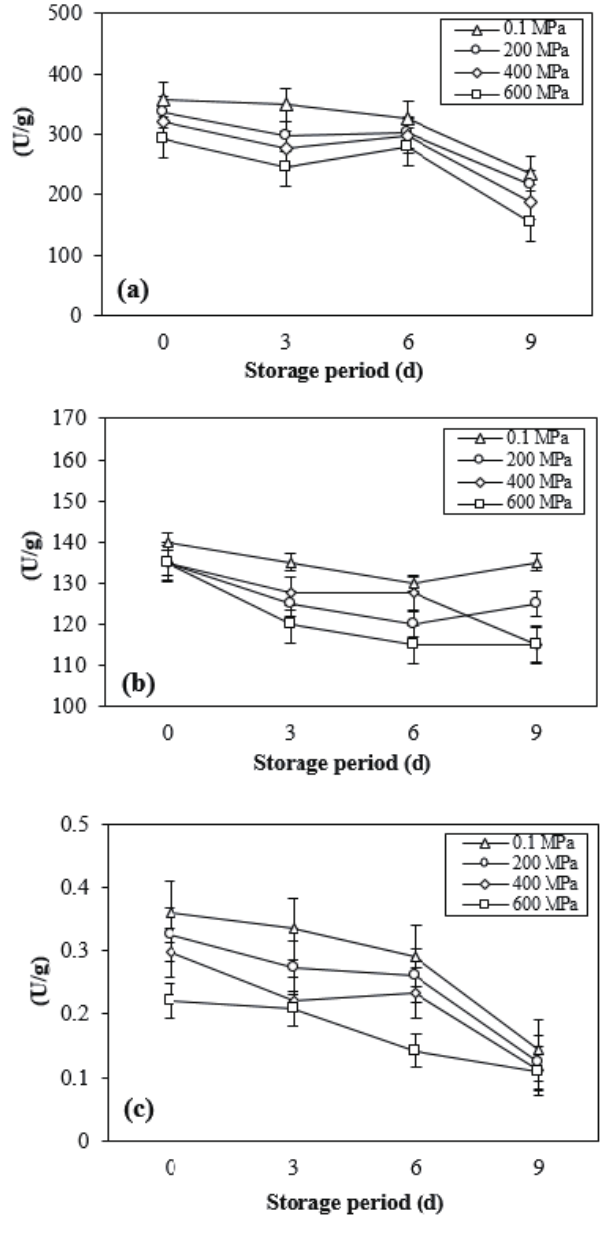
Figure 3. Changes in the activity of catalase (a), superoxide dismutase (b), and glutathione peroxidase (c) of DFD strip loin subjected with different levels of pressure during refrigerated storage under vacuum. These data are presented as mean±standard deviation. DFD,